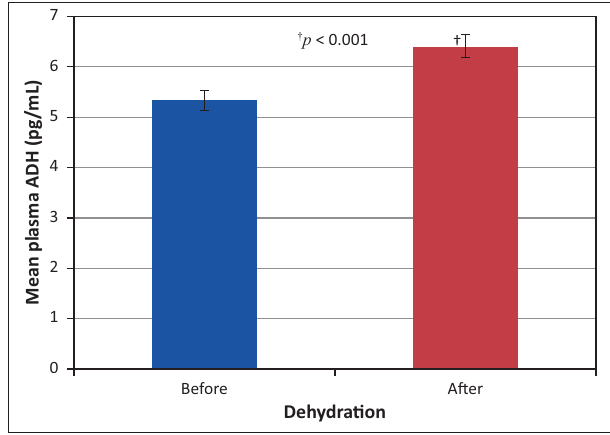
FIGURE 5: Mean plasma antidiuretic hormone concentration before and after dehydration in 50 participants. A paired t -test showed a significant increase ( p < 0.001) in mean plasma antidiuretic hormone from the baseline value of 5.36 pg/mL ± 0.21 pg/mL to 6.40 pg/mL ± 0.20 pg/mL after